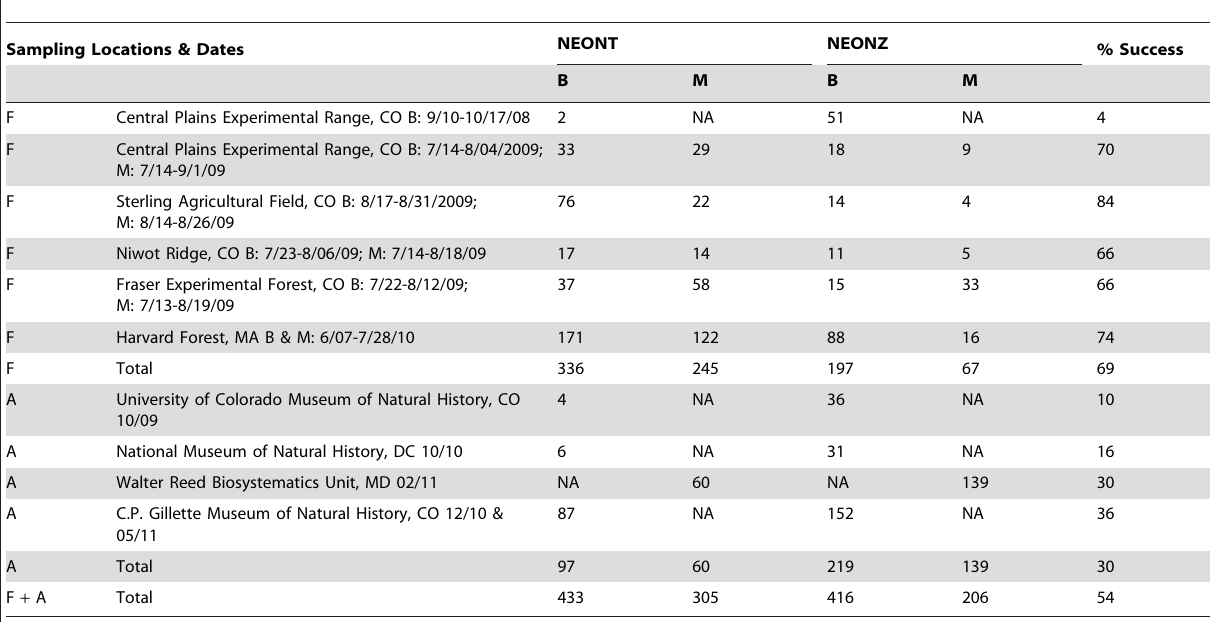
Table 1. Numbers of NEON sub-sampled ground beetle and mosquito specimens sequenced from both field and museum campaigns.